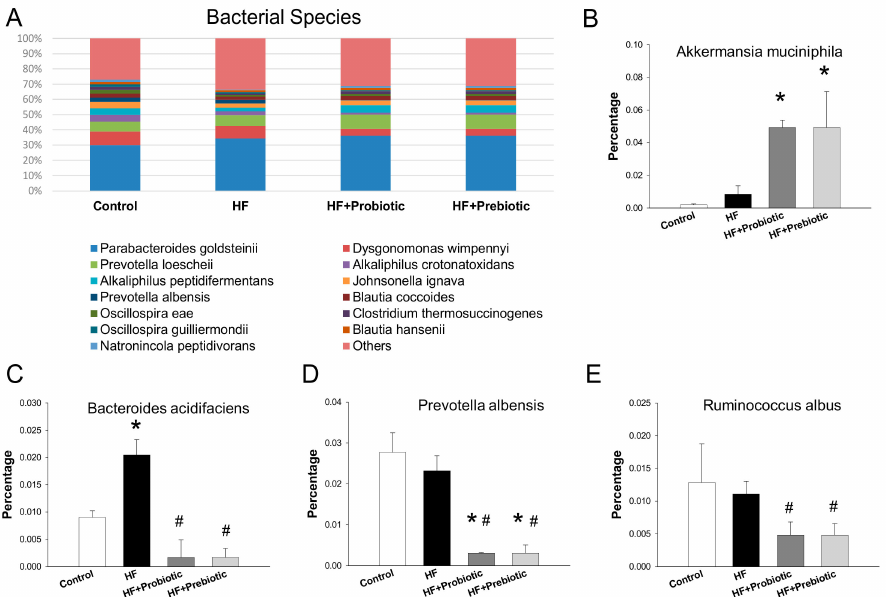
Figure 5. Effect of maternal high-fructose (HF) diet, probiotic Lactobacillus casei , and prebiotic inulin on gene expression of ( A ) Relative abundances of the gut microbiota at the species level; ( B ) the Akkermansia muciniphila ; ( C ) the Bacteroides acidifaciens ; ( D ) the Prevotella albensis ; and ( E ) the Ruminococcus albus . N = 7–8/group. * p < 0.05 versus control; # p < 0.05 versus